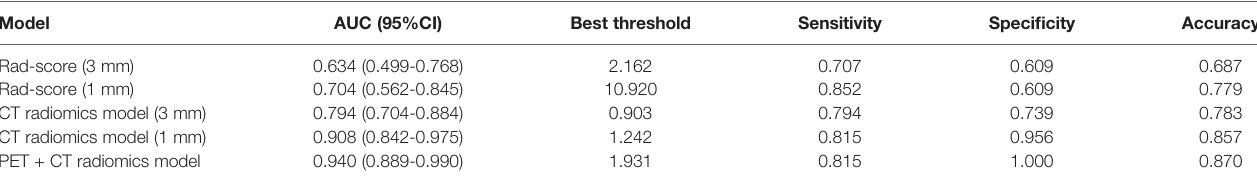
TABLE 3 | Comparison of diagnostic ef fi ciency of different models.